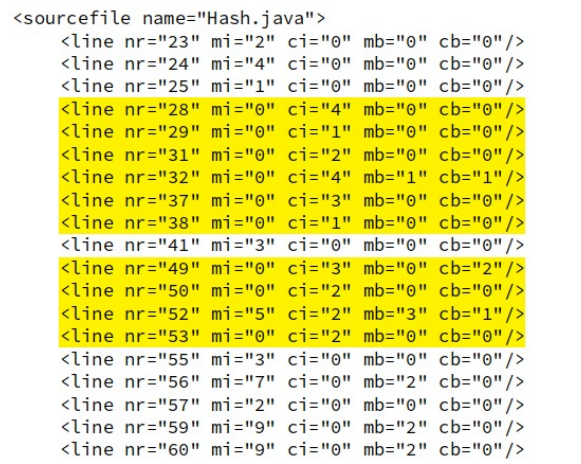
Figure 3. Sample from JaCoCo